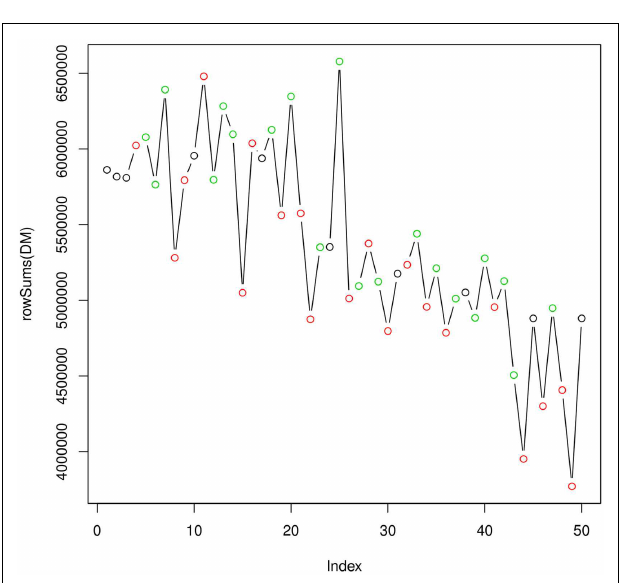
FIGURE 4 |Variation of the integral of theTIC over the analytical run